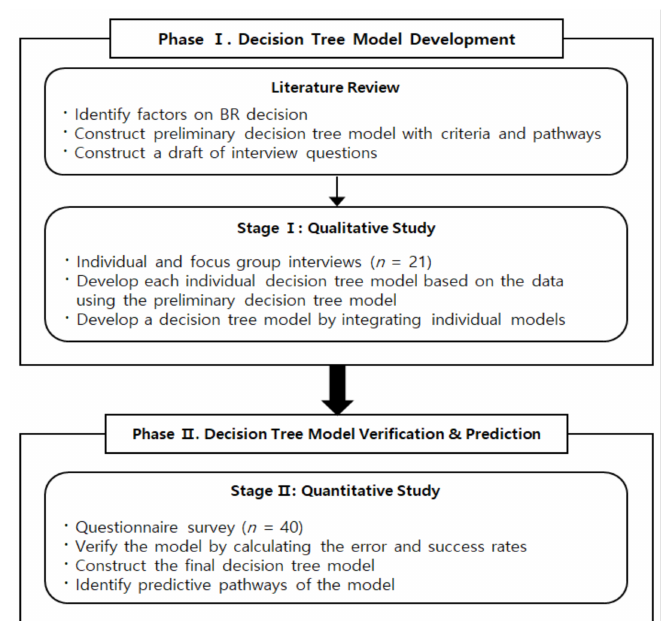
Figure 1. Research process using methodological